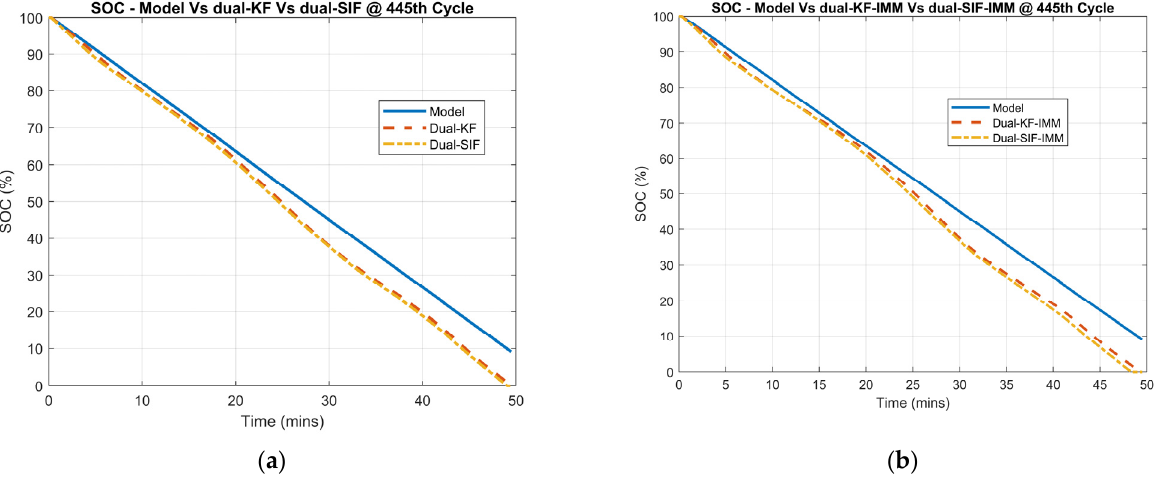
Figure 9. ( a ) Dual-KF and dual-SIF SOC estimates at cycle 445. ( b ) Dual-KF-IMM and dual-SIF-IMM SOC estimates at cycle 445.